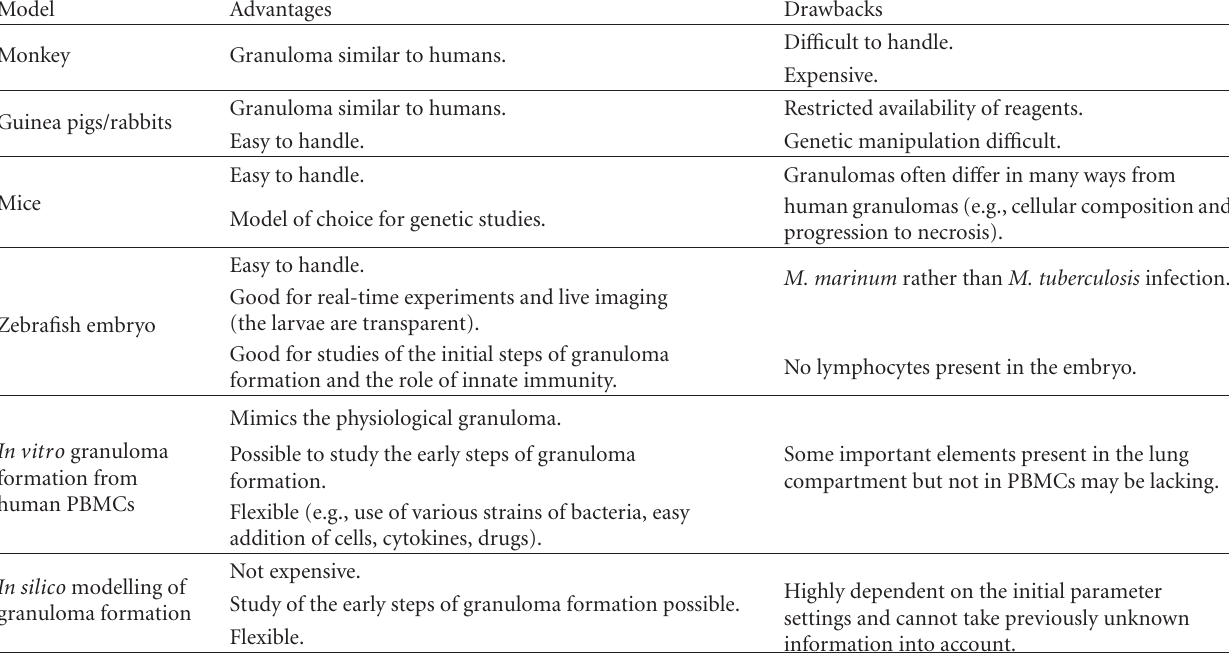
Table 1: Models for studying Mtb infection and the granulomatous